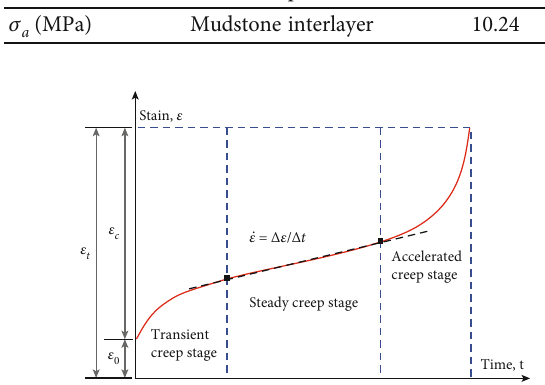
Figure 4: Typical creep curve of rock